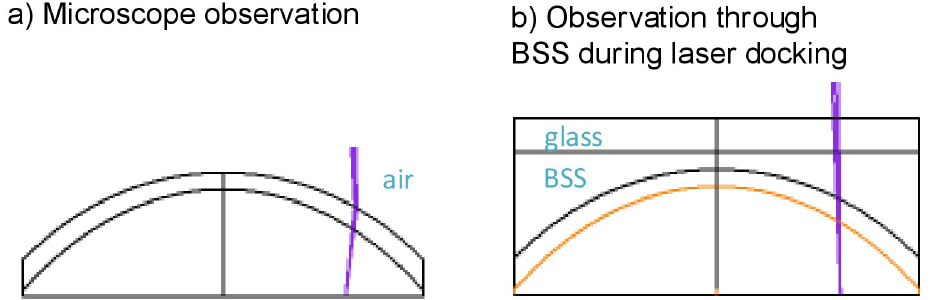
Fig 1. Illustration of the difference in magnification when observing the pupil through the cornea (a) by microscope through the air–cornea interface versus (b) during liquid interface laser docking.